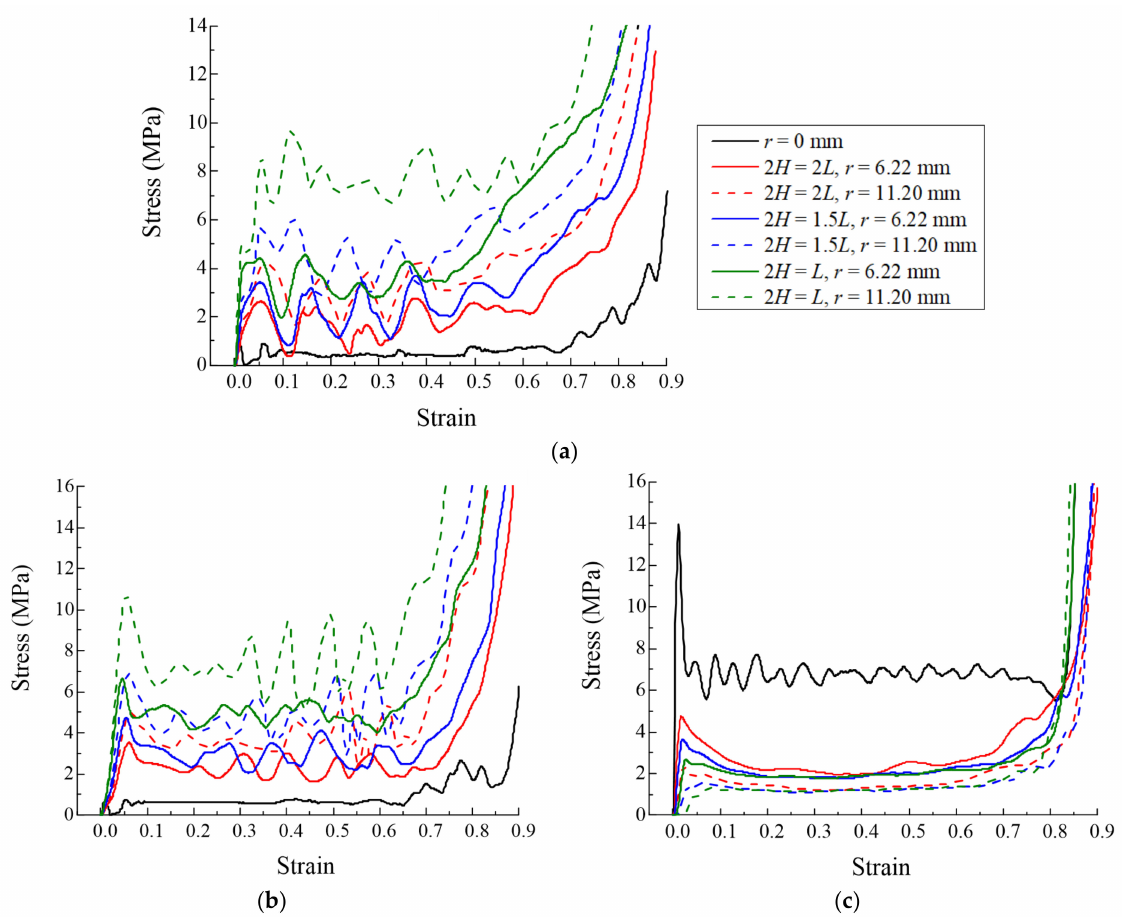
Figure 5. Stress versus strain curves of different models ( a ) in the in-plane direction along the y-coordinate, ( b ) in the in-plane direction along the x-coordinate, and ( c ) in the out-of-plane